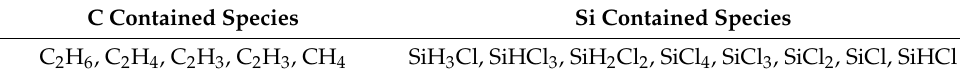
Table 3. List of C or Si contained intermediate species participate as reactants. C Contained Species